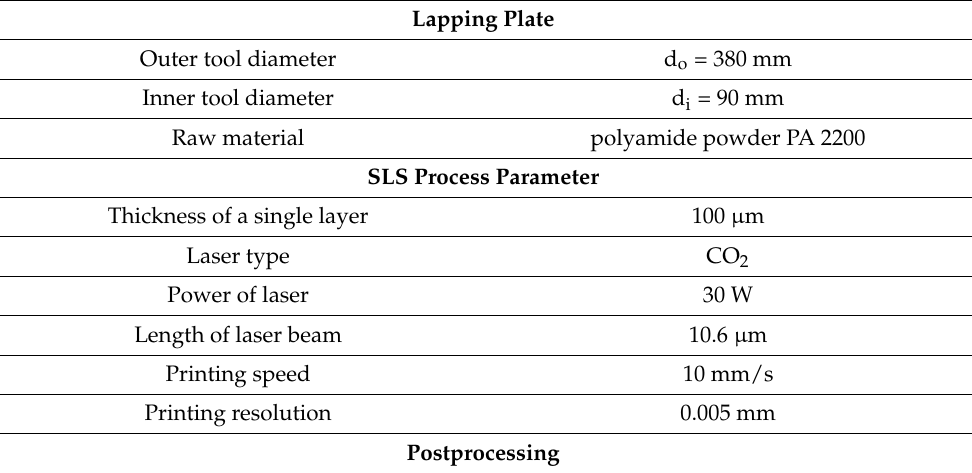
Table 1. Specification of the lapping tool and the parameters of the SLS process.